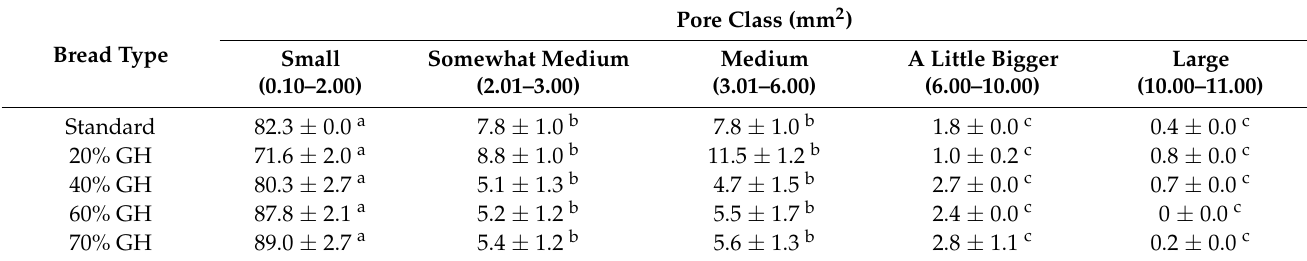
Table 3. Pore size analysis of standard bread versus the GH breads with promoters (20–70%).